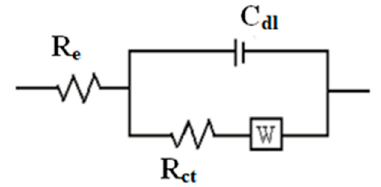
Figure 10. Equivalent electrical circuit.